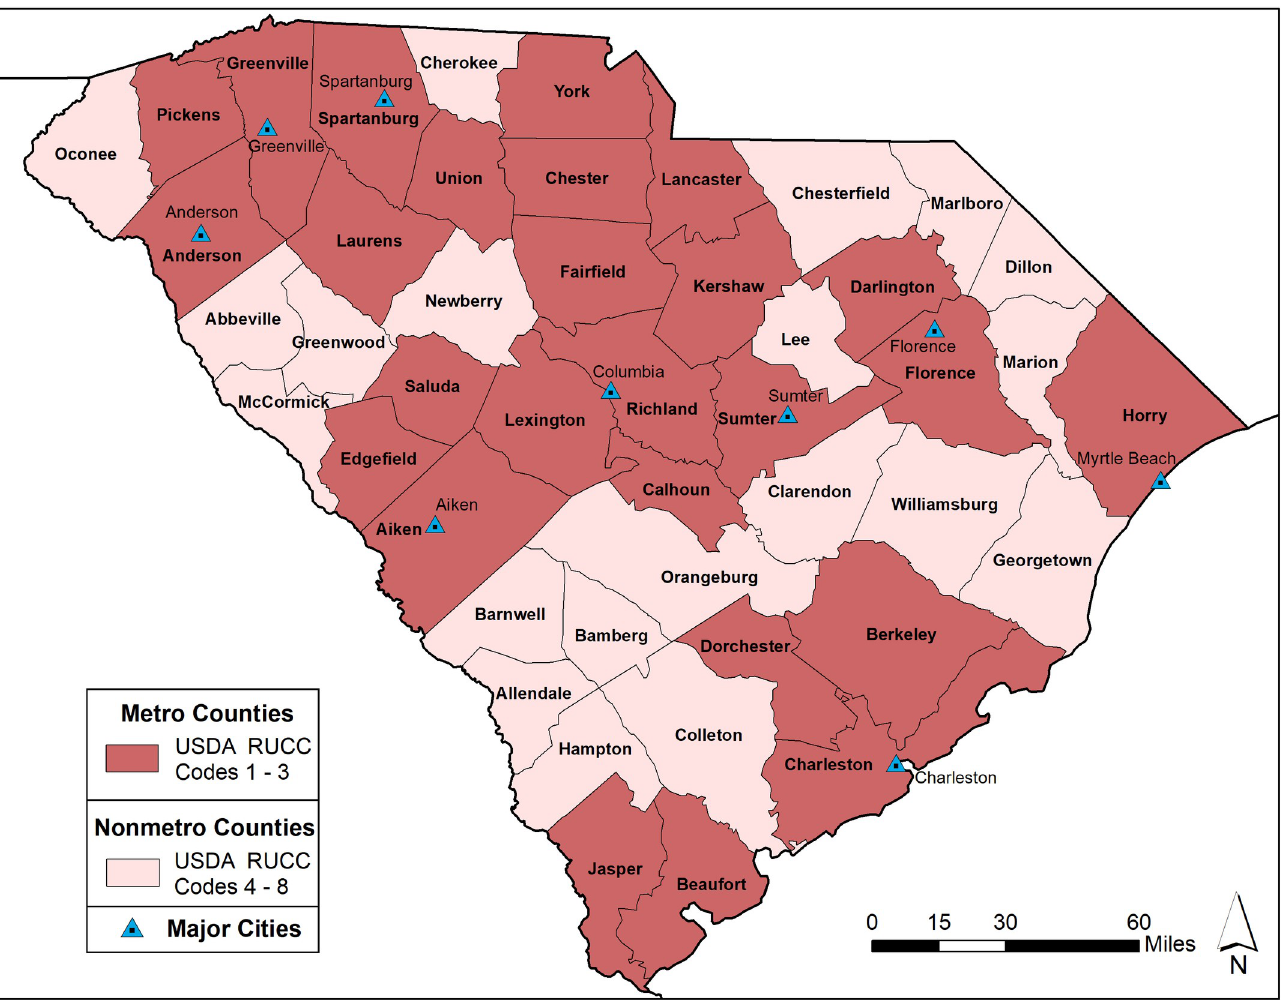
Fig 1. USDA 2013 metro and non-metro South Carolina county designations. County and state boundaries are retrieved from the U.S. Census Bureau (https:// www.census.gov/geographies/mapping-files/time-series/geo/carto-boundary-file.html).